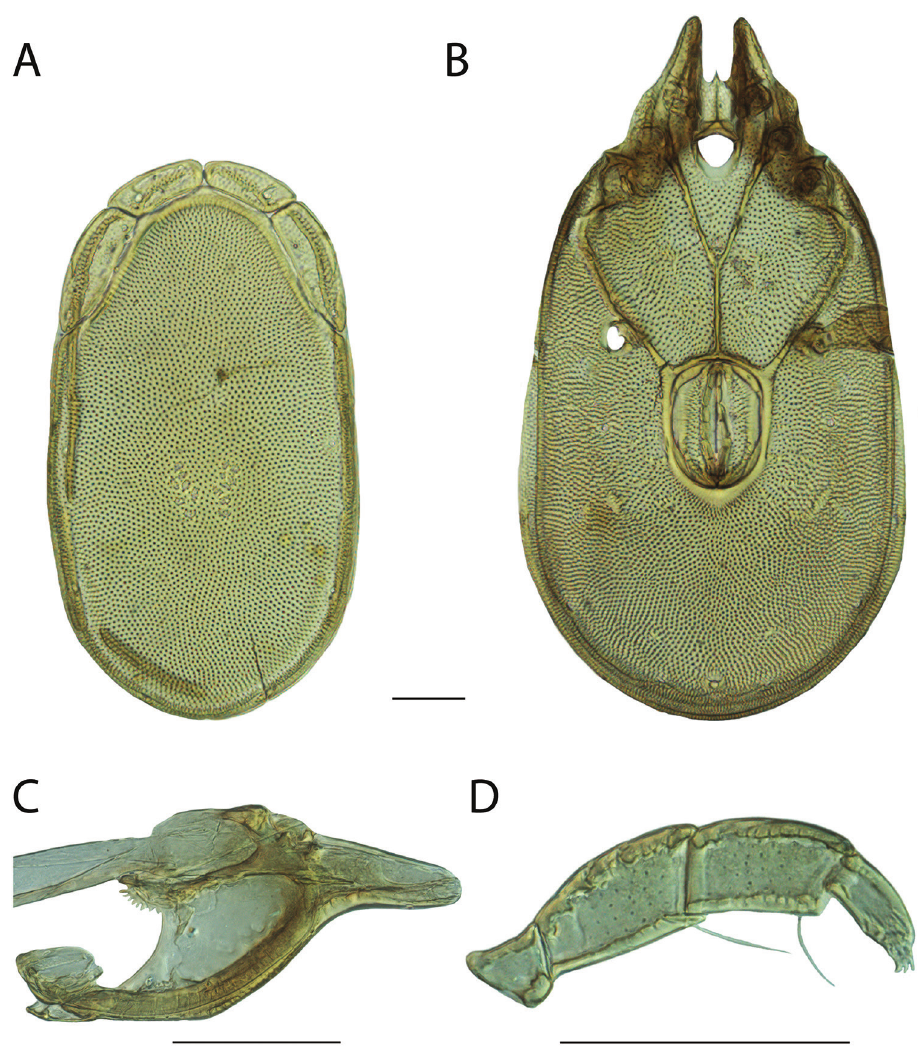
Figure 31. Torrenticola boettgeri male: A dorsal plates B venter (legs removed) C subcapitulum D pedipalp (setae not accurately depicted). Scale = 100